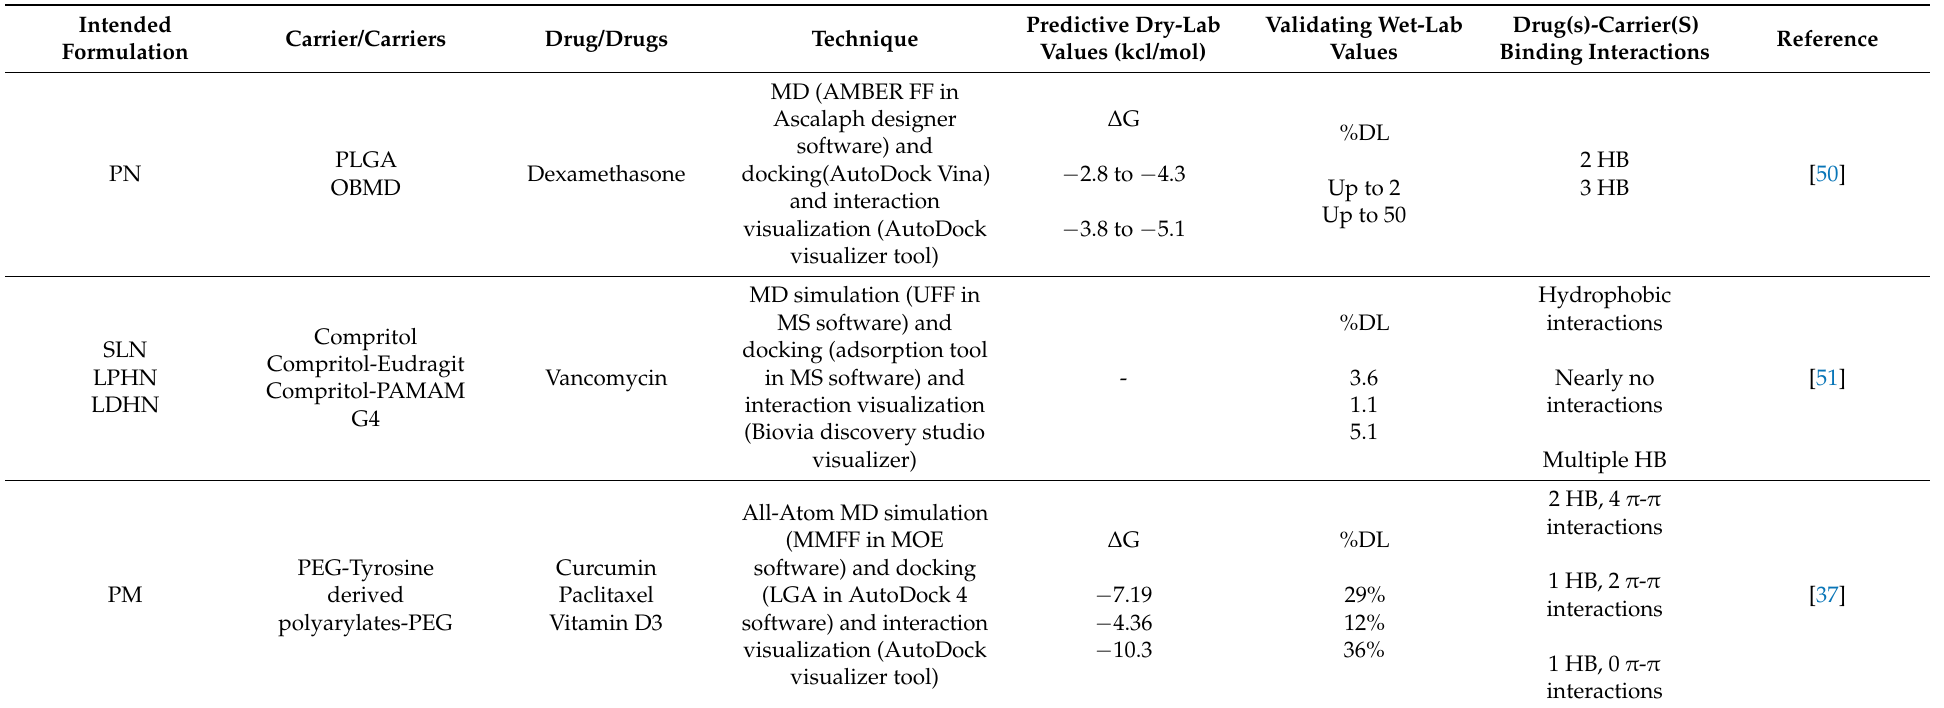
Table 4. Cases of binding site analysis in simulated lipid and polymeric nanocarriers and their